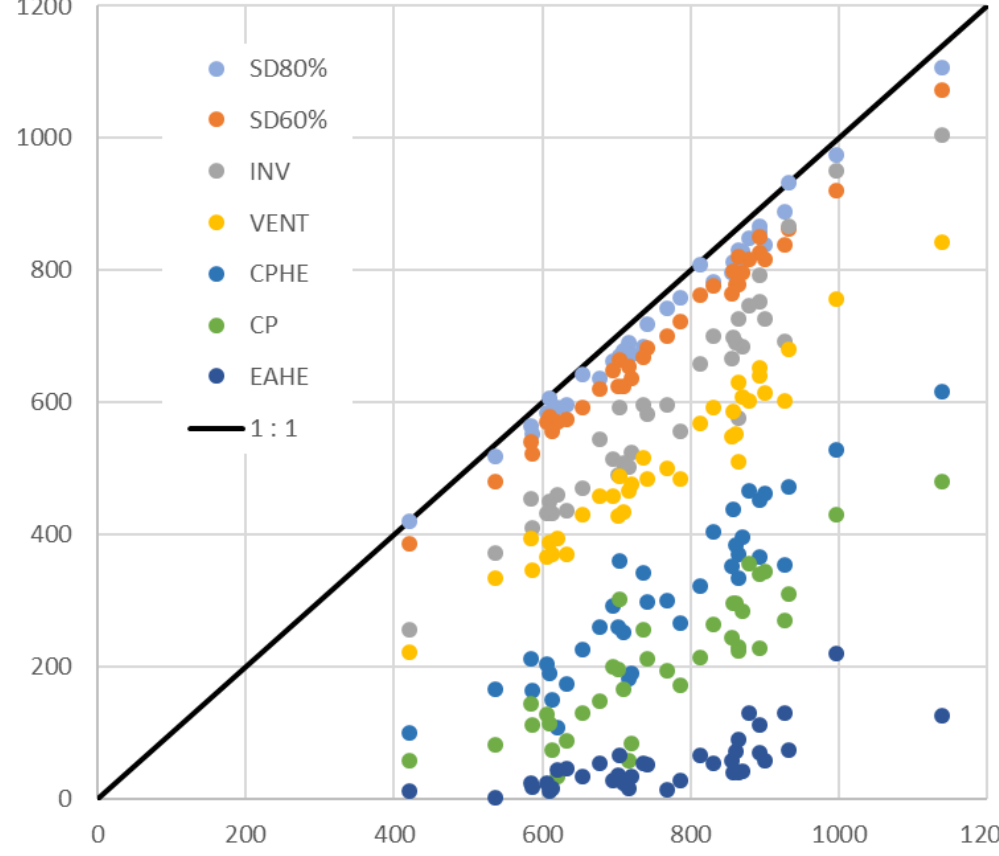
Figure 1. Efficacy of heat stress reduction by the use of AMs shown by the exceedance frequency P T25 (h/a) for an indoor temperature threshold of 25 ◦ C as an HS index. Adaptation measures: stocking density SD80%; stocking density SD60%; inversion of the resting and activity periods INV; doubling the ventilation rate VENT; cooling pads and heat exchanger CPHE; cooling pads CP; and earth-air heat exchanger EAHE [53] .